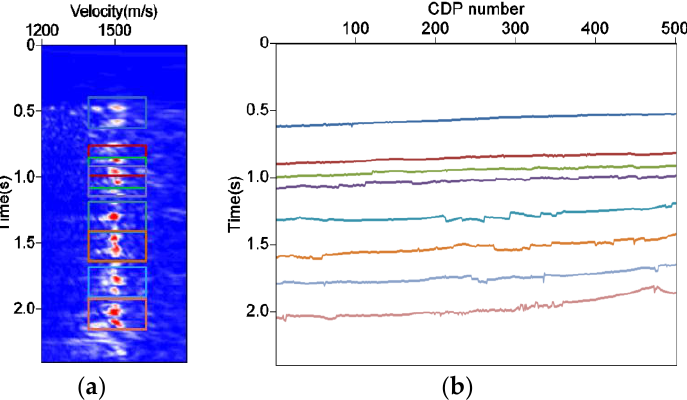
Figure 13. ( a ) Tracking windows; ( b ) the result of tracking paths.